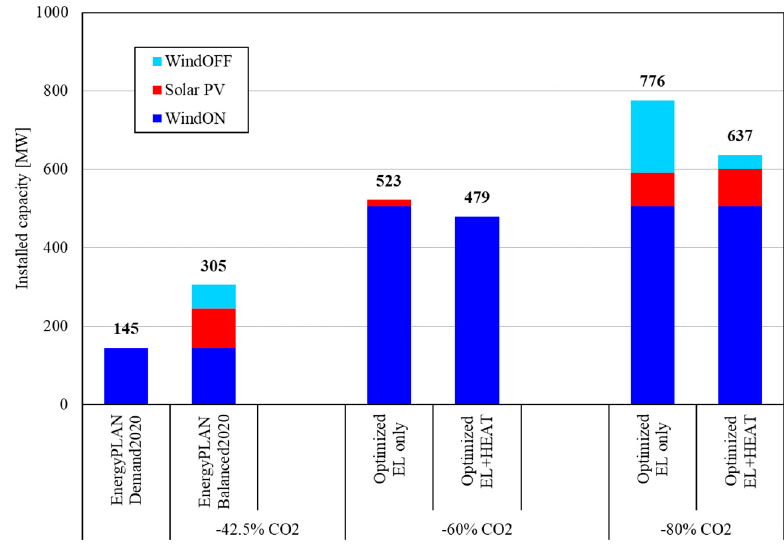
Figure 9. Installed capacities for selected scenarios and cases.